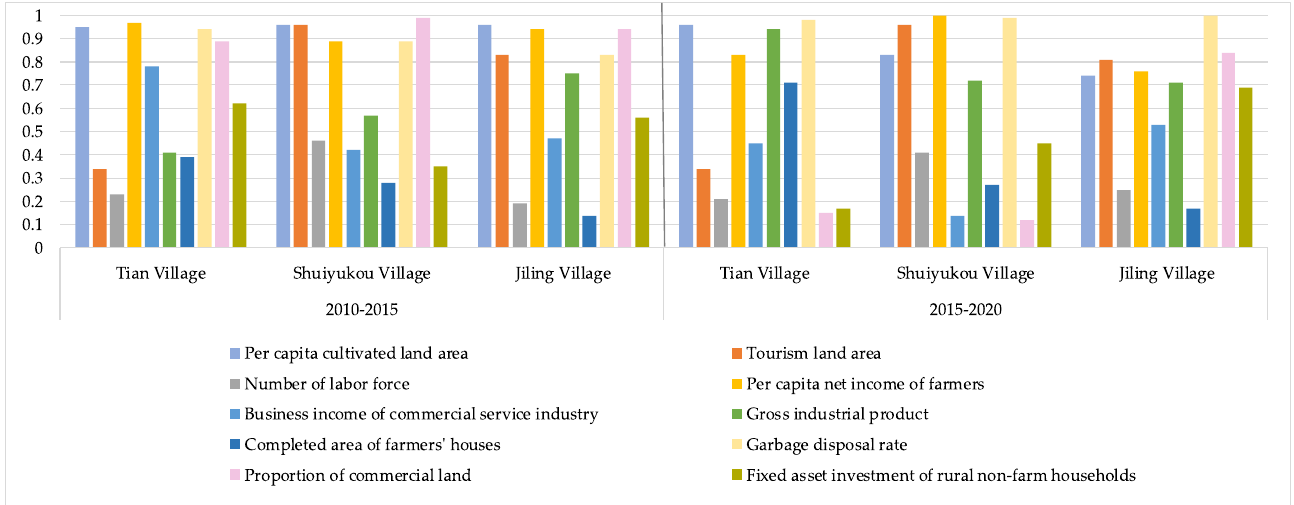
Figure 6. The grey relational coefficient of the symbiosis degree and influencing factors between the production land and living land in rural settlements.